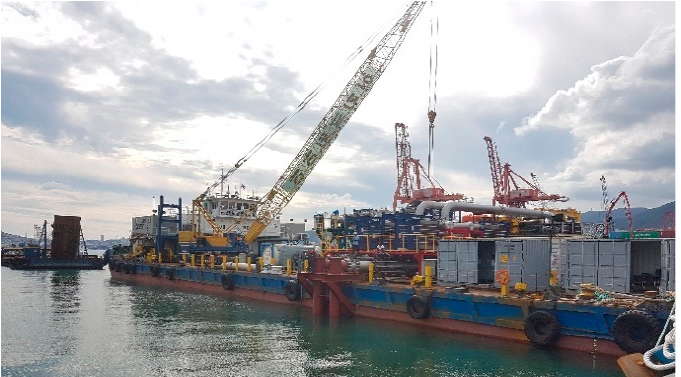
Figure 1. Demonstration of 1 MW floating OTEC in Republic of Korea.